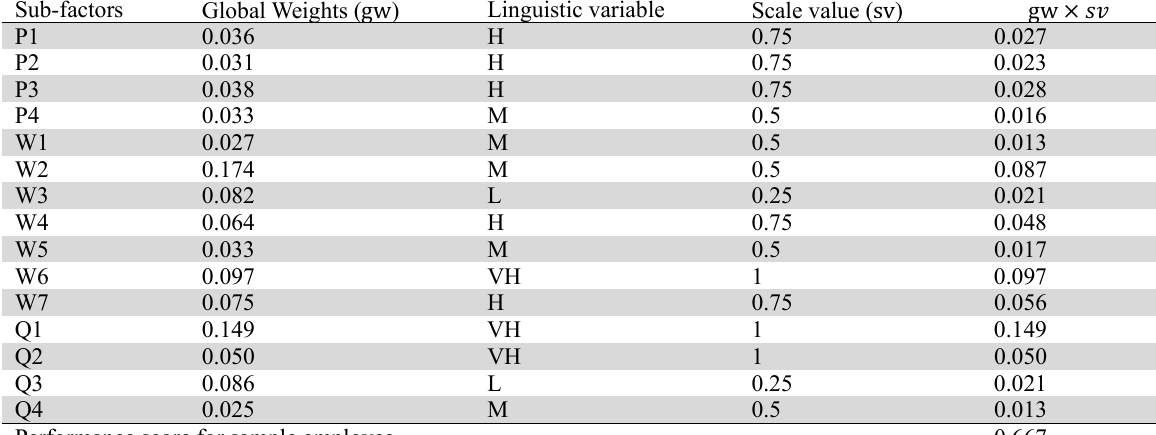
Computed performance for a sample employee with the proposed fuzzy ANP model Sub-factors Global Weights ( gw ) Linguistic variable Scale value ( sv ) gw (cid:3400)